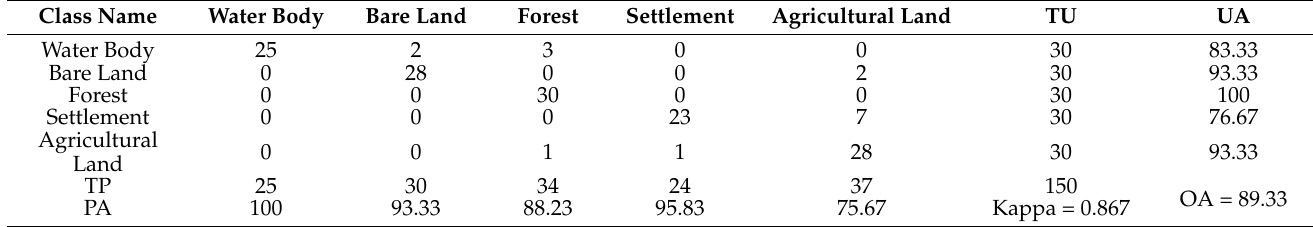
Table 7. Accuracy Assessment of Classified Map of November